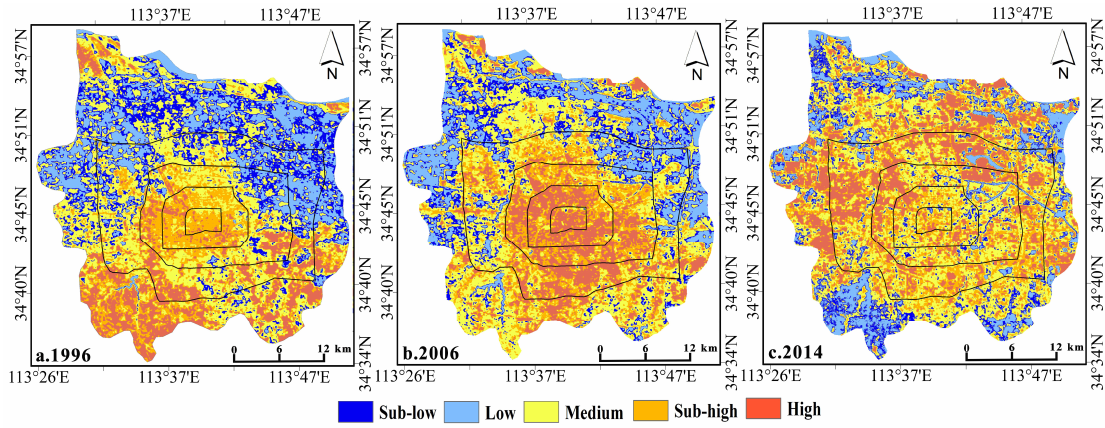
Figure 3. Spatial patterns of different LST levels in Zhengzhou in ( a ) 1996, ( b ) 2006, and ( c ) 2014. According to the LST profile analysis of Zhengzhou City (Figure 4), the results revealed that the zones closest to the city center did not show the highest mean LST between 1996 and 2014. The mean LST value reached its peak approximately 5 km from the city center before it reduced gradually. In addition, the pattern of mean LST along the LST profile shows evidence for the presence of the UHI phenomenon in the study area; more specifically, the LST values were small in 1996 but became larger in 2006 and even larger in 2014 because of the expansion in the amount of impervious surface.